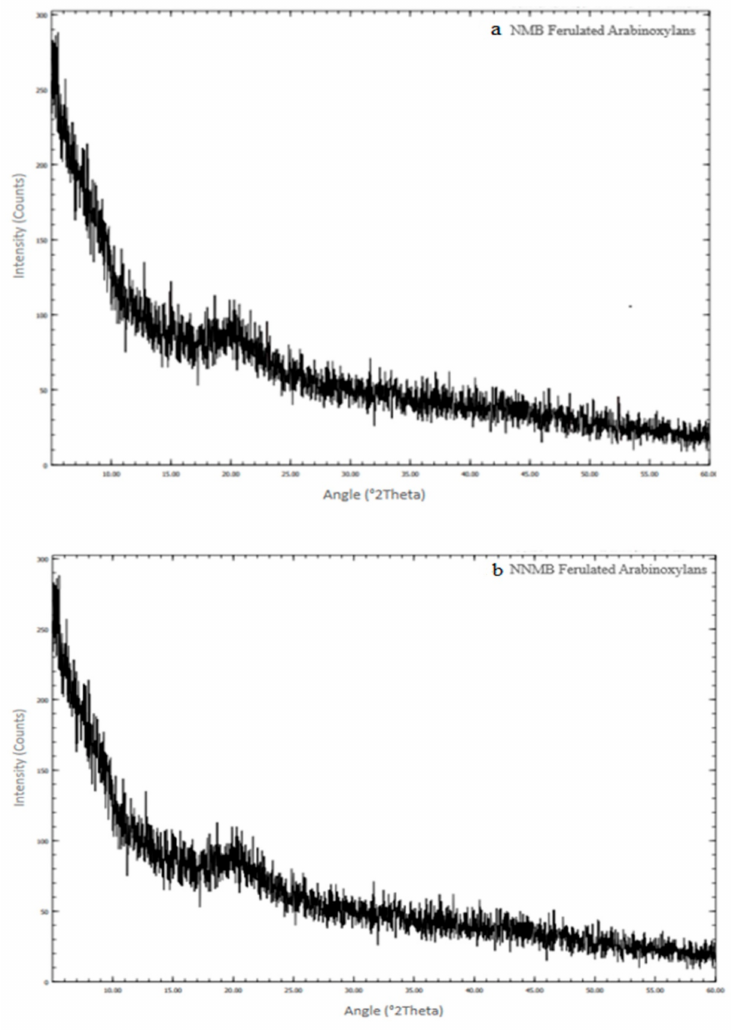
Figure 4. XRD spectrum of ( a ) NMB and ( b ) NNMB ferulated